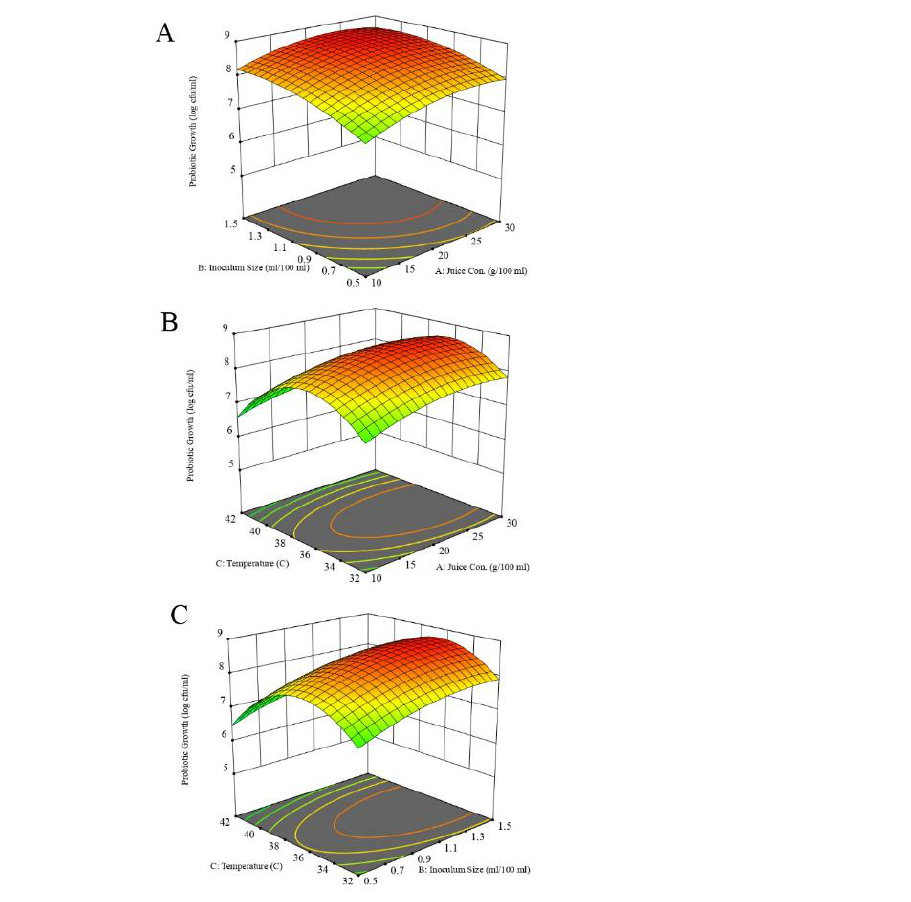
Figure 2. 3D response surface plot presenting the effect of interactions of independent variables on Lactobacillus plantarum growth. ( A ) Juice concentration vs. inoculum size; ( B ) temperature vs. juice concentration; ( C ) temperature vs. inoculum size.